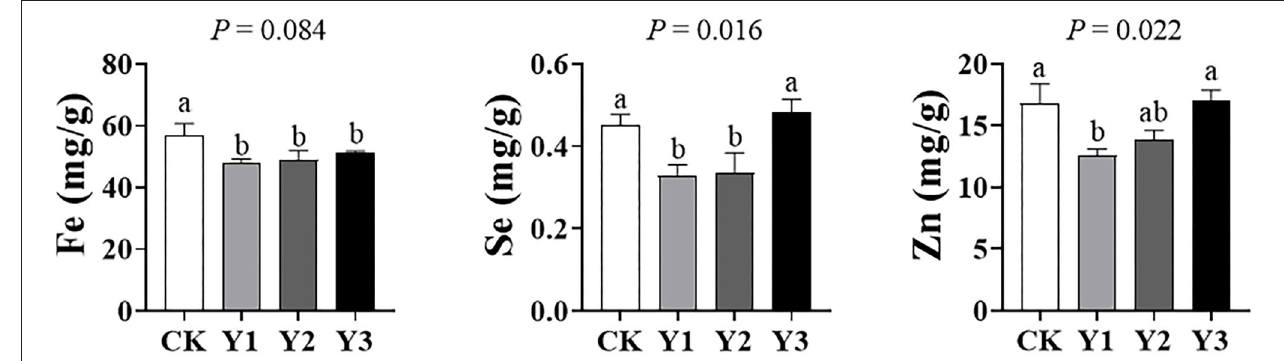
FIGURE 6 | Effects of dietary AOE on meat trace elements in breast muscle of